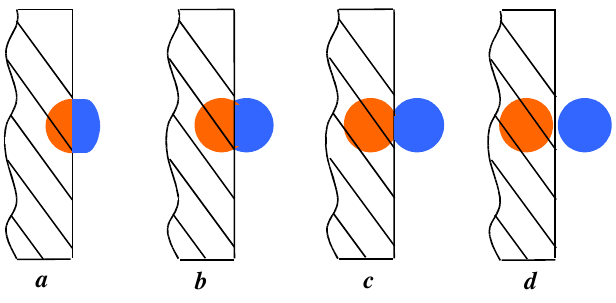
FIG. 10. (Color) Schematic sequence of the exit of the macro- particle from the cathode; in blue the particles, in red the